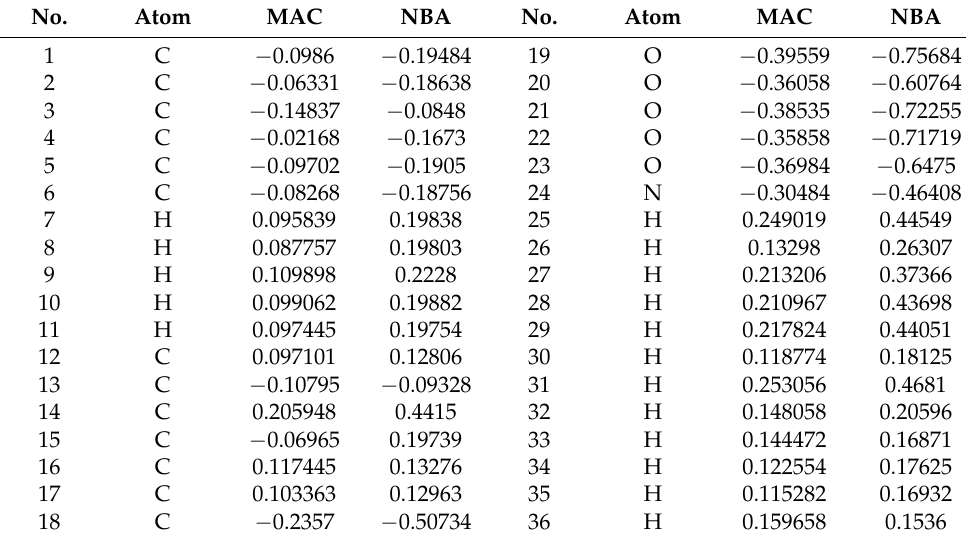
Figure 5. ( a ) Solid MEP, ( b ) open MEP, ( c ) MAC and NPA charges and ( d ) MAC vs. NPA relation. Table 4. NPA and MAC charges. Table 4. NPA and MAC